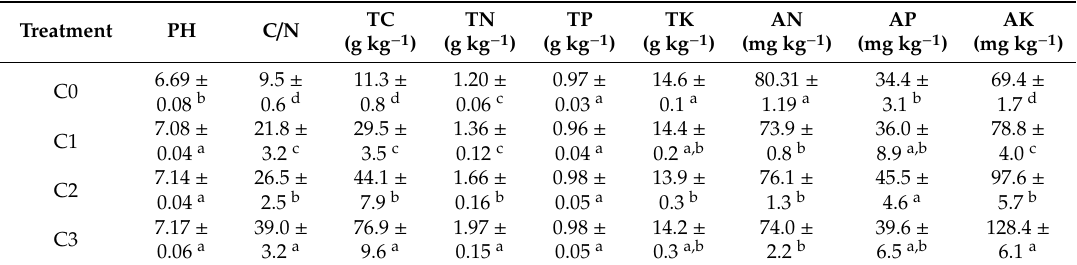
Table 1. Soil physicochemical properties at di ff erent biochar addition rates.